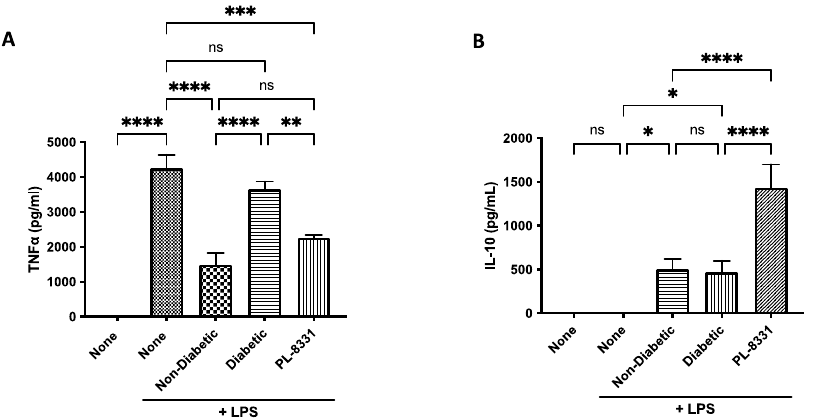
Figure 5. The effects of PL-8331-treatment of diabetes on RPE regulation of LPS-stimulated macrophages. The RPE eyecup conditioned media (CM) were collected from 24 h cultures of RPE eyecups of non-diabetic, diabetic, and PL-8331-treated diabetic mice. The macrophages were treated with the CM, stimulated with LPS, and 24 hrs later, the culture media was assayed for ( A ) TNF α and ( B ) IL-10 by ELISA. ( A ) The production of TNF- α from LPS-stimulated macrophages treated with RPE eyecup CM from non-diabetic mice was significantly suppressed, as well as the macrophages treated with RPE eyecup CM from PL-8331-treated diabetic mice. There were no statistical differences between the effects of the RPE eyecup CM in non-diabetic and PL-8331-treated diabetic mice. The RPE eyecup CM from diabetic mice did not suppress TNF- α production by the macrophages. ( B ) The production of IL-10 from LPS-stimulated macrophages treated with RPE eyecup CM from PL-8331-treated diabetic mice was significantly enhanced over the amount of IL-10 from macrophages treated with the CM of RPE eyecups from non-diabetic and diabetic mice. Statistical differences between the mean (pg/mL) ± SEM of the cultures were calculated (* p ≤ 0.05, ** p ≤ 0.01, *** p ≤ 0.005, **** p ≤ 0.001, ns = not significantly different; N = 10). An effect of treating diabetic mice with PL-8331 is the restoration or maintenance